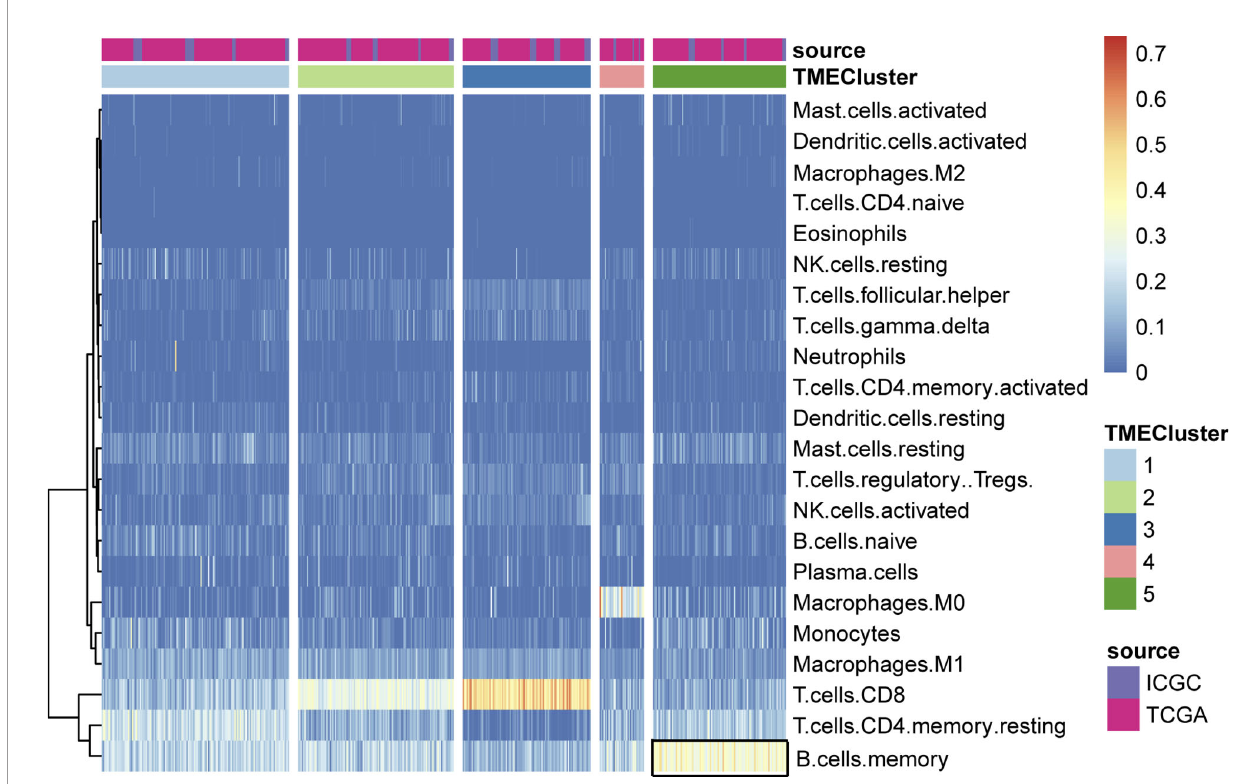
FIGURE 3 | Unsupervised clustering of TME cells for patients in the two cohorts. We assessed the differential in fi ltrating levels of immune cells in various clusters, where the memory B cells exhibited signi fi cantly enrichment in TME